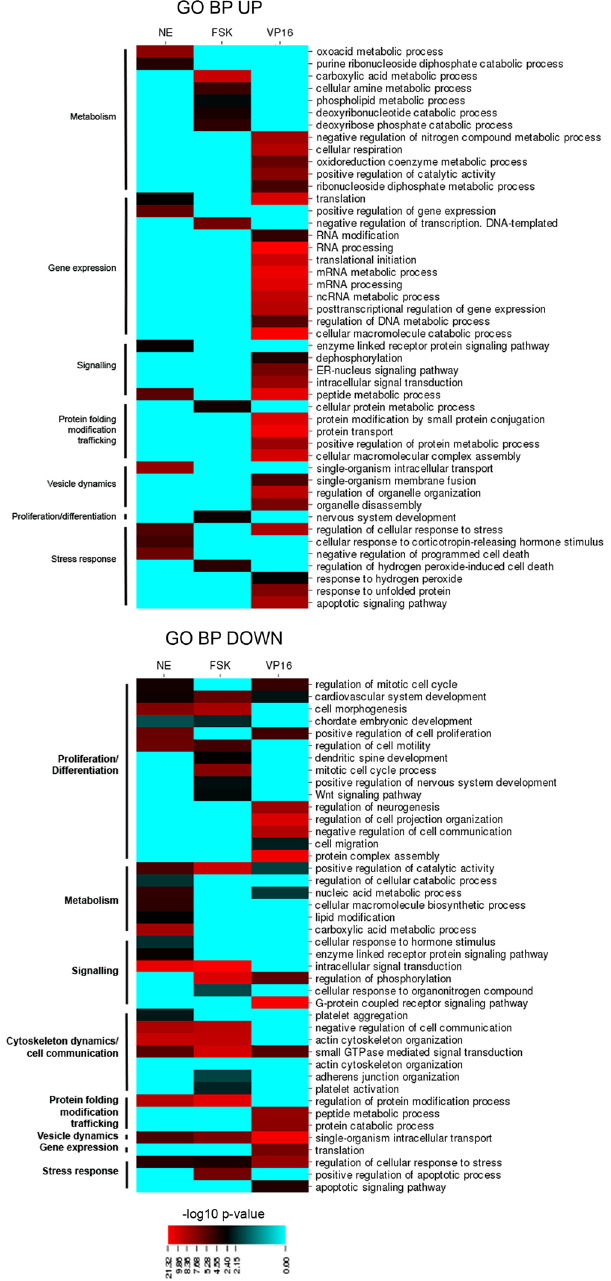
Figure 4. Functional enrichment analysis with GO Biological Pathway. Heatmaps show -log 10 p- values for each enriched GO Biological Pathway (BP) term (described in the right) in the pair-wise comparisons NE- CT; FSK-CT; VP16-Null. GOs were manually grouped into larger categories (left) for better understanding of functional changes among conditions. p- values correspond to an enrichment/depletion two-sided hypergeometric statistical test, corrected for multiple comparisons by Bonferroni